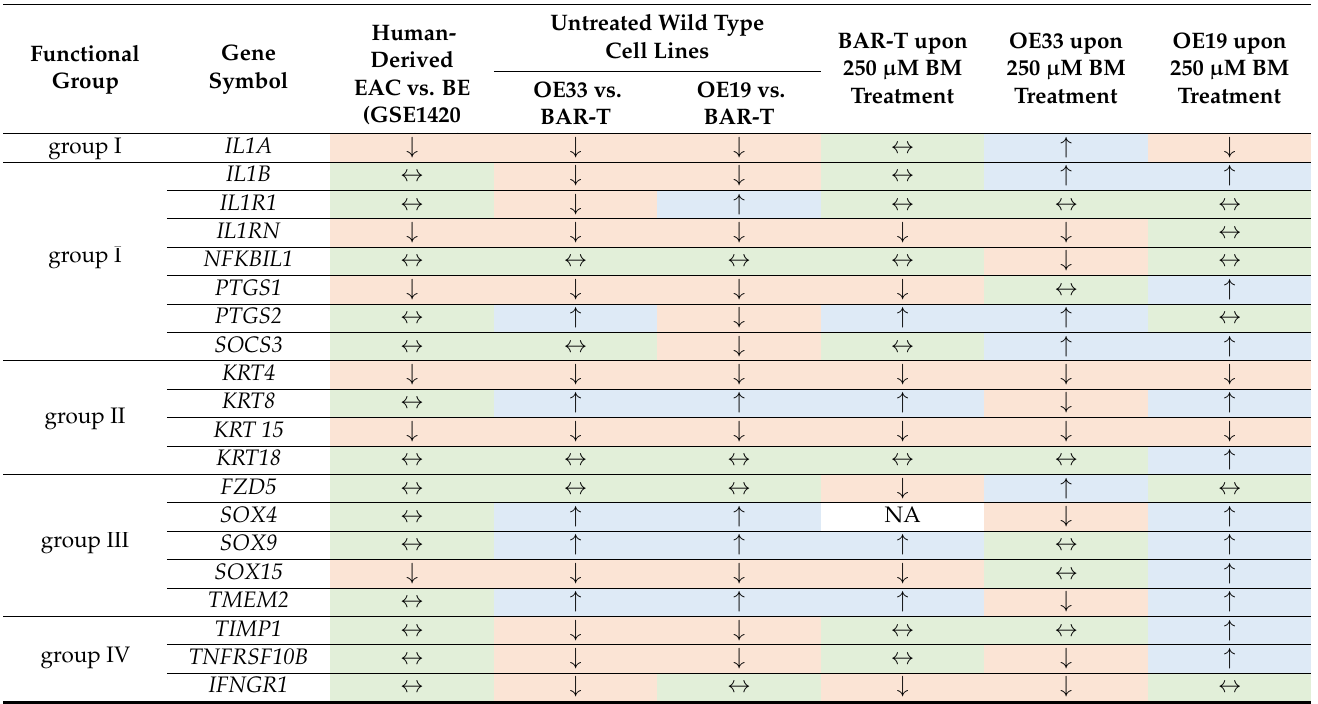
Table 5. Summarized comparison of gene expression profiles observed between in silico analysis of human Barrett’s esophagus (BE) and esophageal adenocarcinoma (EAC) biopsies, untreated wild type cell lines and BAR-T, OE33 and OE19 cells exposed or not to acidified bile mixture (BM) in an in vitro model of GERD. An arrow up ( ↑ ) and blue background indicate significant upregulation; an arrow down ( ↓ ) and pink background indicate significant downregulation; a double-sided arrow ( ↔ ) and green background indicate no changes in mRNA expression; NA—no